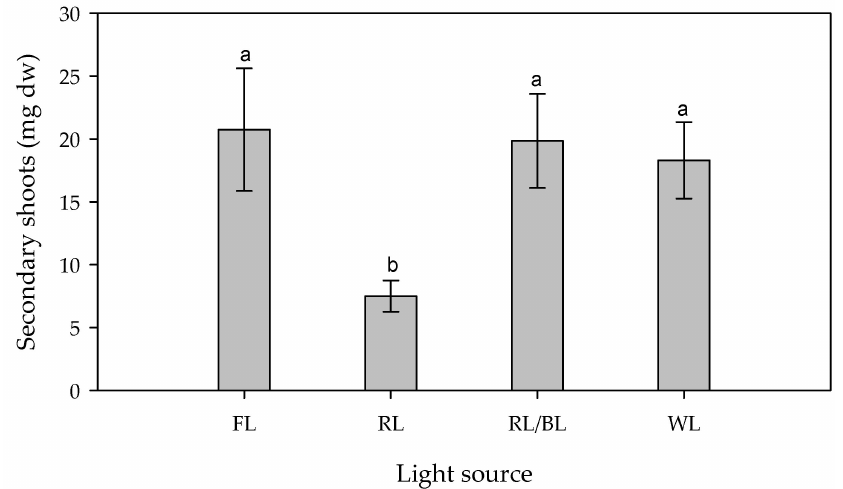
Figure 2. Effect of different light source (FL = Fluorescence, RL = predominantly Red, RL/BL = Red/Blue, and WL = White lights) on the dry weight (mg) of in vitro secondary shoots. Different letters indicate significant differences for p < 0.05, error bars indicate standard error of the